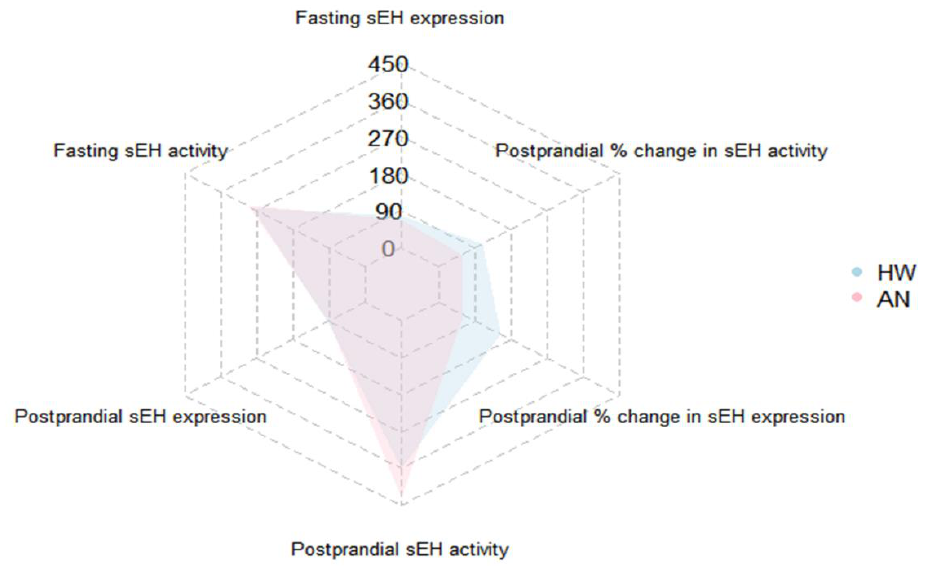
Figure 4. Polygonal graph summarizing mean sEH levels at fasting and postprandial timepoints and mean postprandial sEH changes (%) in healthy women (blue) and women with anorexia nervosa (pink). HW: healthy women; AN: anorexia nervosa.